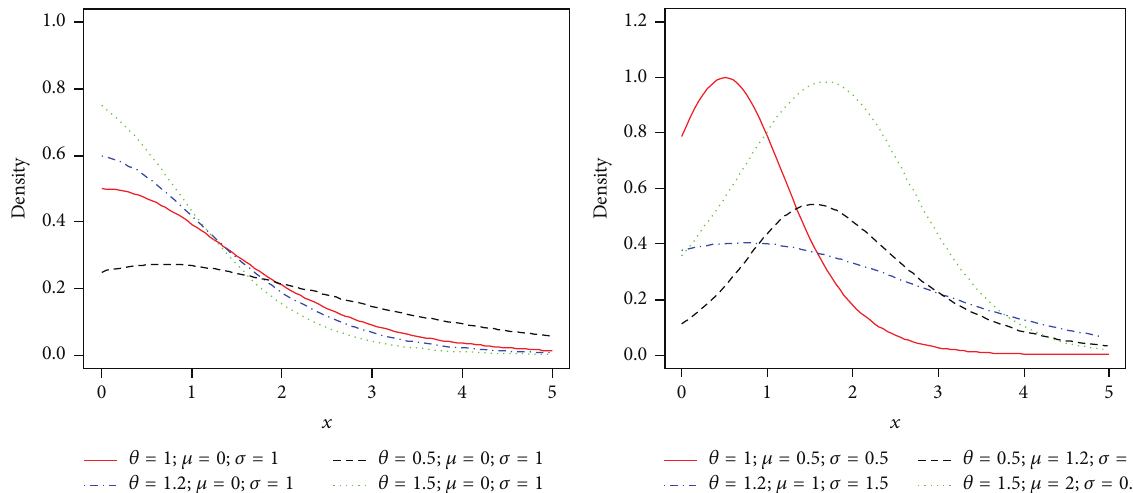
Figure 1: Probability density function of the type I generalized half-logistic distribution for the indicated values of 𝜃 , 𝜎 , and 𝜇 .